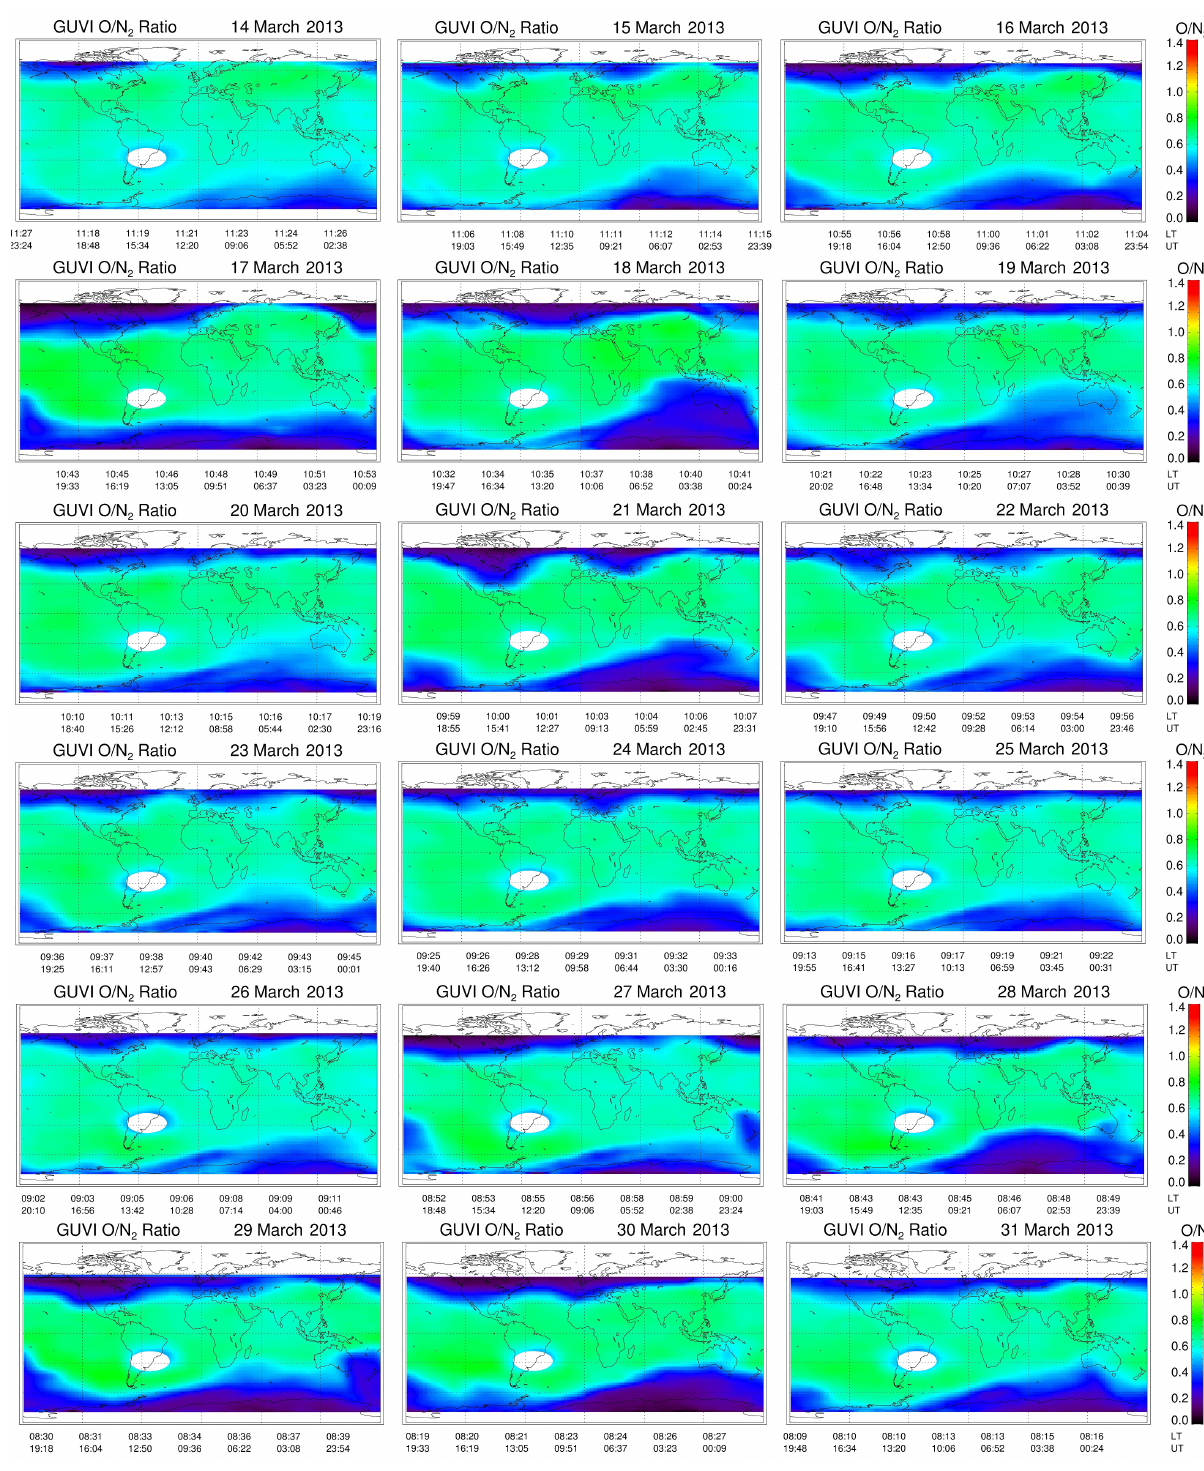
Figure 4. O / N 2 ratios measured by the GUVI instrument onboard the TIMED satellite, for the period 14–31 March